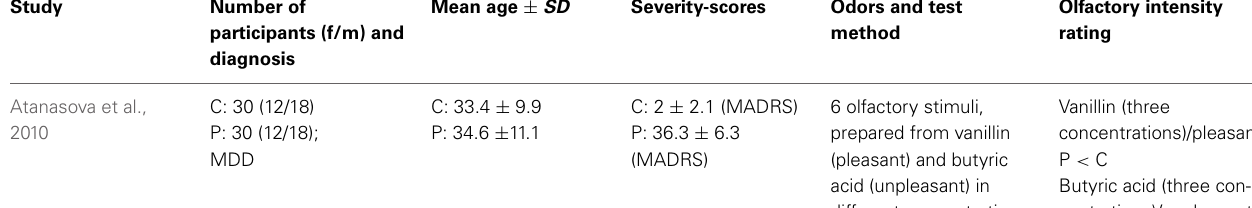
Table 4 | Summary of studies of odor intensity ratings in affective